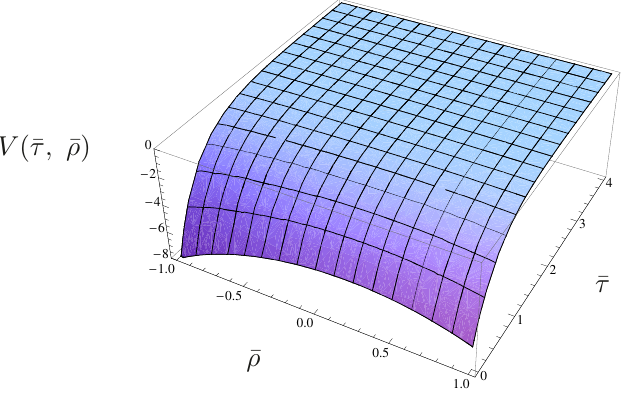
Figure 5 . The figure shows the moduli potential V (¯ τ, ¯ ρ ) in the type IIB theory for the case of R (Y) = 1, A Y = 1, A H = A p = A D p = 0, A O p